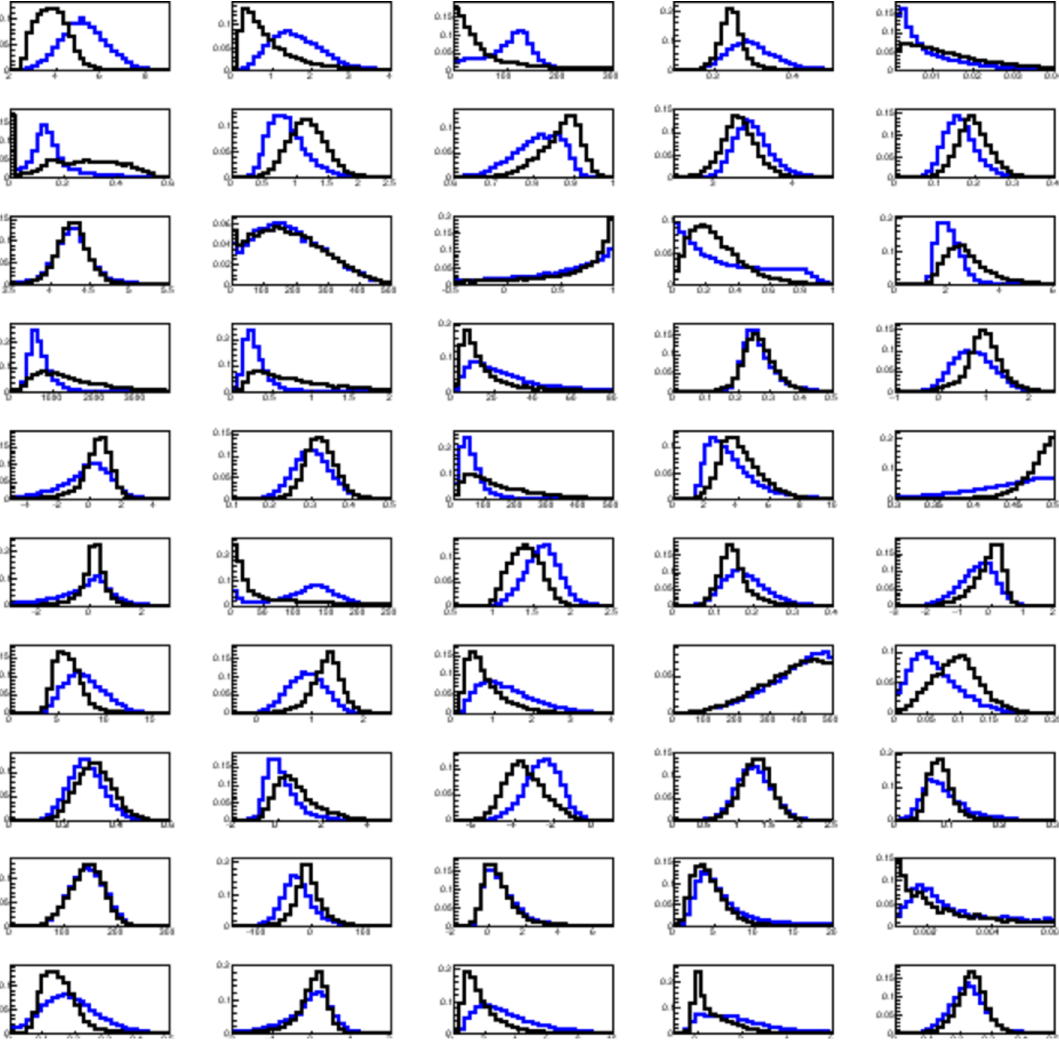
Figure 15 . Normalized and standardized distributions of the 50 features of electron-neutrino candidate interactions in MiniBooNE. Distributions of real electron interactions are in black, and backgrounds are in